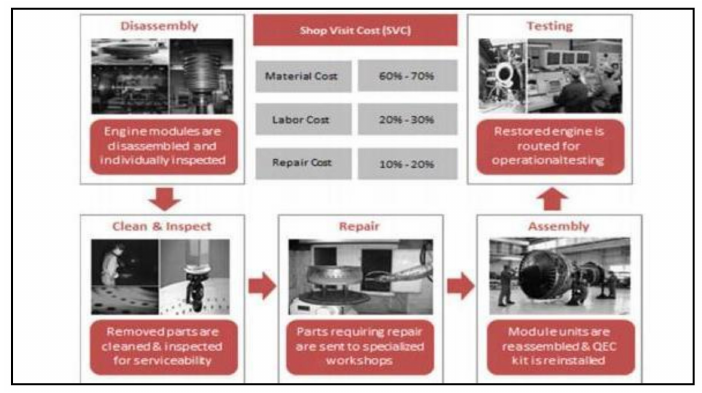
Figure 3. Cycle of breakdown of engine during a shop